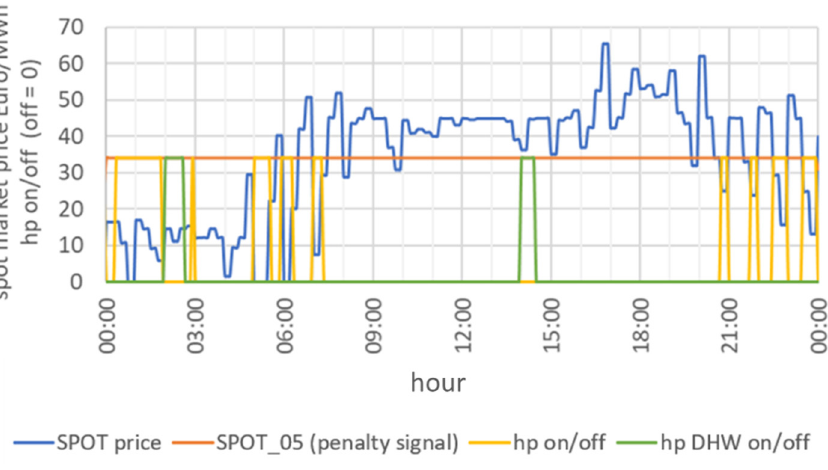
Figure 4. Example for the penalty signal SPOT_05.